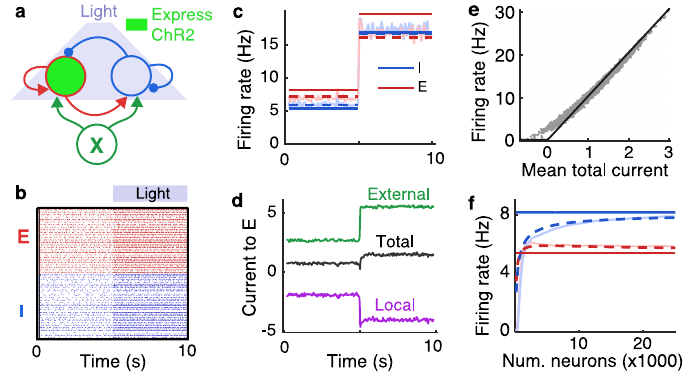
Fig 1. Imprecise balance under optogenetic stimulation. a) Schematic. A population of recurrently connected excitatory (red) and inhibitory (blue) spiking neuron models receive synaptic input from an external population ( X ; green) of Poisson-spiking neurons. Optogenetic stimulation of excitatory neurons was modeled by an extra inward current to the excitatory population at 5s. b) Spike rasters from 50 randomly selected excitatory (red) and inhibitory (blue) neurons from recurrent network. c) Average firing rate of excitatory (red) and inhibitory (blue) neurons in the recurrent network from simulations (light solid), from the balanced network approximation (Eq (3); solid dark) and from the corrected approximation (Eq (4); dashed). d) Mean synaptic currents to 200 randomly selected excitatory neurons in the recurrent network from external inputs ( X ; green), from the local population ( E + I ; purple) and the total synaptic current (black). Currents are measured in units of the neurons’ rheobase (rheobase/ C = 10.5 V/s). e) m Mean firing rates plotted against mean input currents to all neurons in populations E and I (gray dots) and a rectified linear fit to their relationship (black line). f) Mean firing rates from identical simulations without stimulation except the total number of neurons, N , in the recurrent network was modulated while scaling synaptic weights and ffiffiffiffi p connection probabilities so that (cid:15) (cid:24) 1 = (see Methods). Solid light curves are from simulations, solid dark from Eq N (3), and dashed from Eq